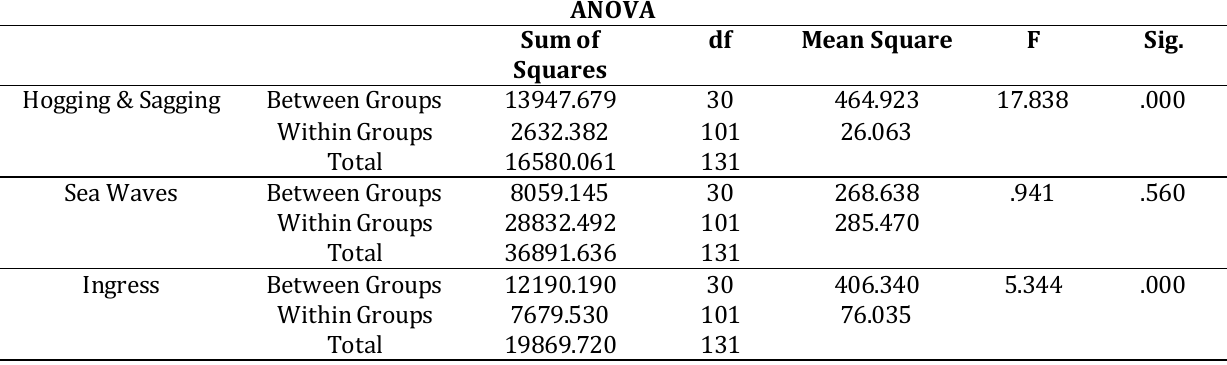
Table 7: ANOVA for identified factors ANOVA Sum of df Mean Square F Sig. Squares Hogging & Sagging Between Groups 13947.679 30 464.923 17.838 .000 Within Groups 2632.382 101 26.063 Total 16580.061 131 Sea Waves Between Groups 8059.145 30 268.638 .941 .560 Within Groups 28832.492 101 285.470 Total 36891.636 131 Ingress Between Groups 12190.190 30 406.340 5.344 .000 Within Groups 7679.530 101 76.035 Total 19869.720